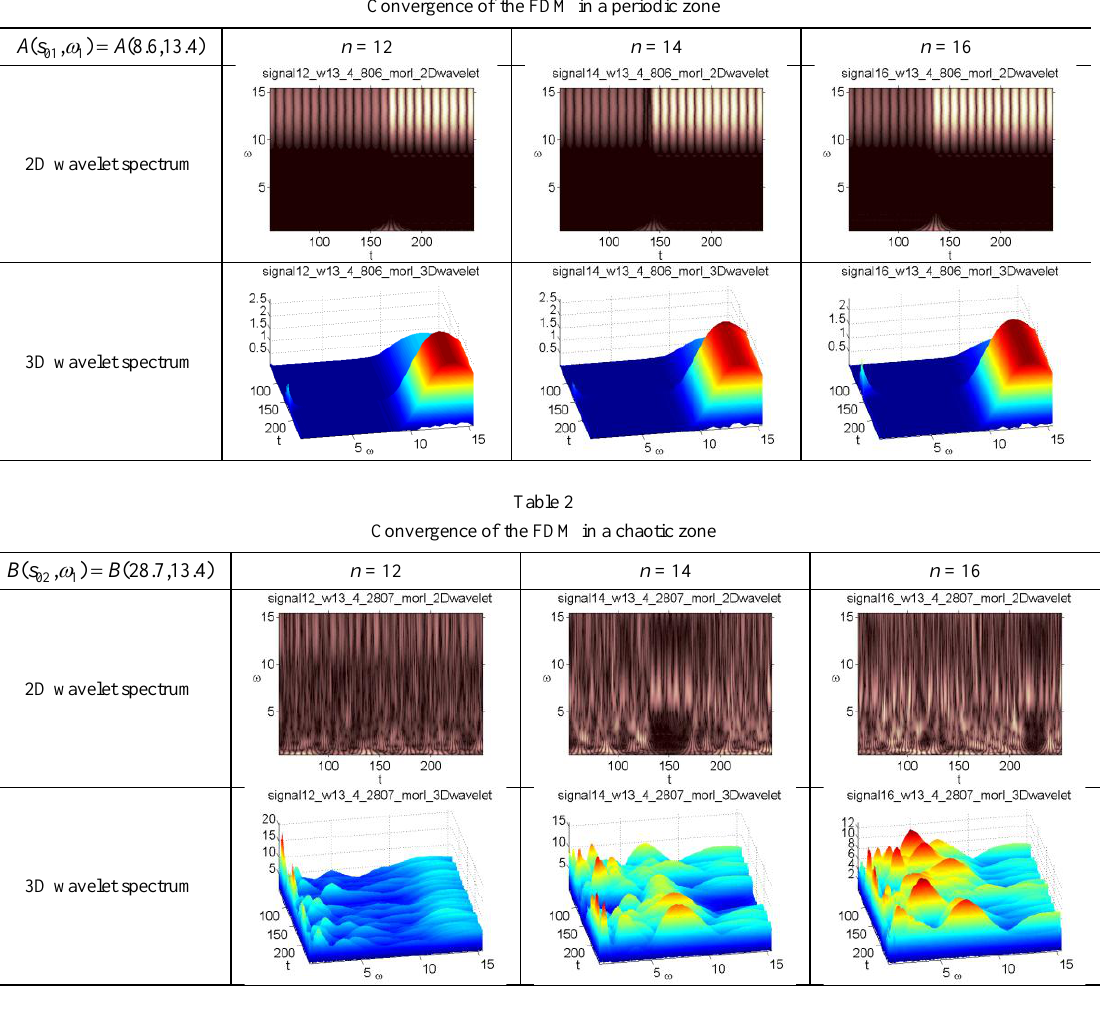
Convergence of the FDM in a periodic zone